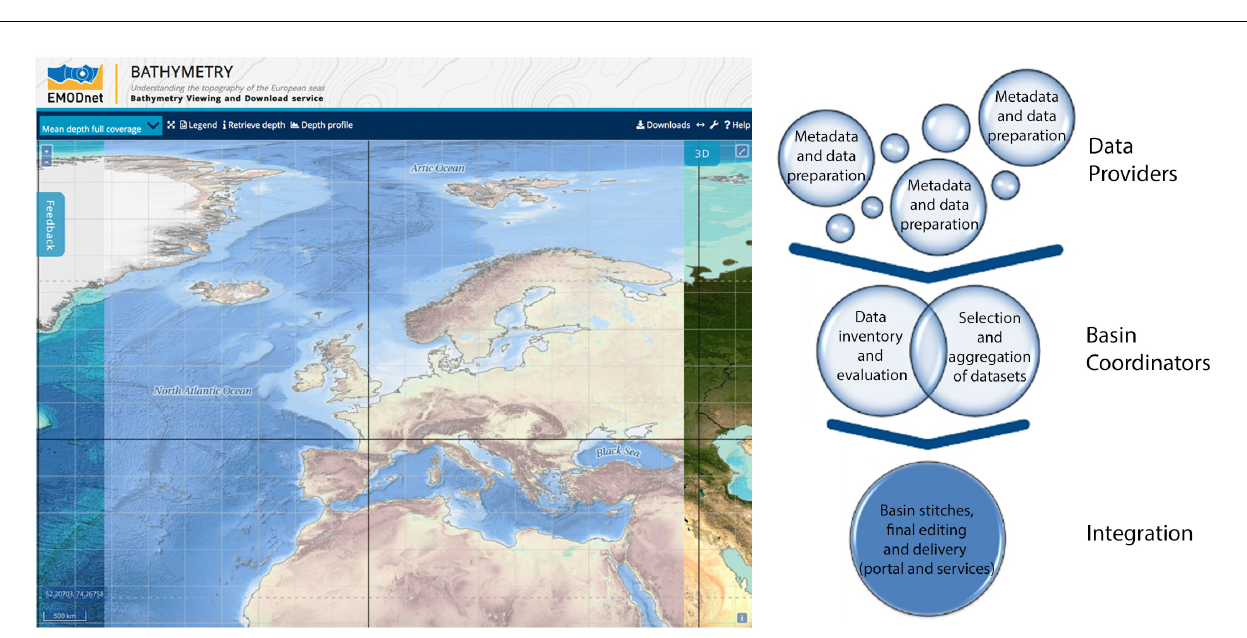
FIGURE 4 | EMODnet Bathymetry grid (version 2018) around the European waters (www.emodnet-bathymetry.eu) and schematic representation of the tasks and roles of each of the contributors of the EMODnet Bathymetry distributed